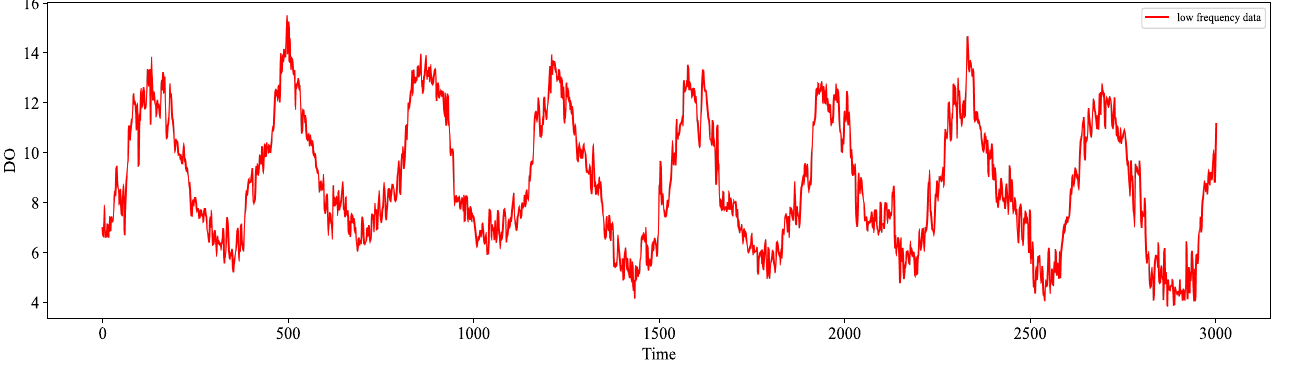
Figure 9. Water quality indicator DO decomposition low-frequency data.